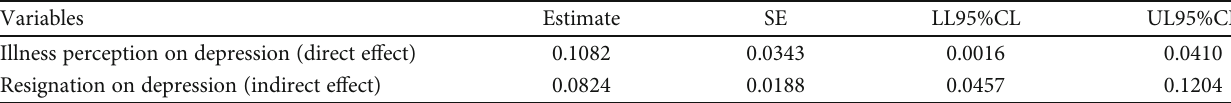
Table 5: Bootstrap results for the mediation